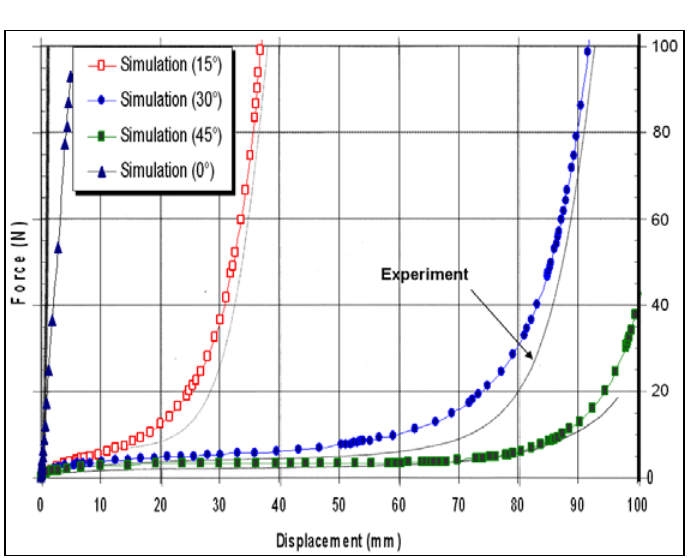
Figure 6. Load force- displacement of the fabric specimen for different fibre